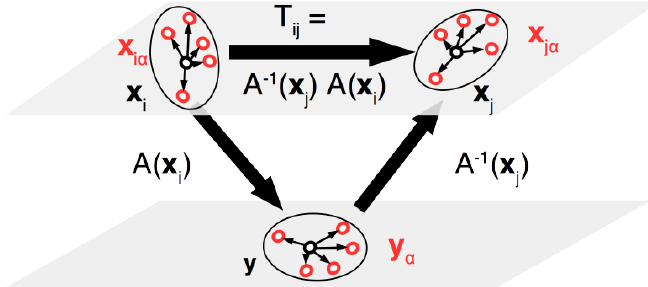
Figure 2. A linear transformation T ij between resolved or unresolved multiple images located around x i and x j (black circles) in the image plane of the same source located around y (black circle) in the source plane is equal to a product of distortion matrices, A ( x ) . Thus, without employing any source properties, the local lens properties represented by the matrix entries of A ( x ) are inferred from the T ij